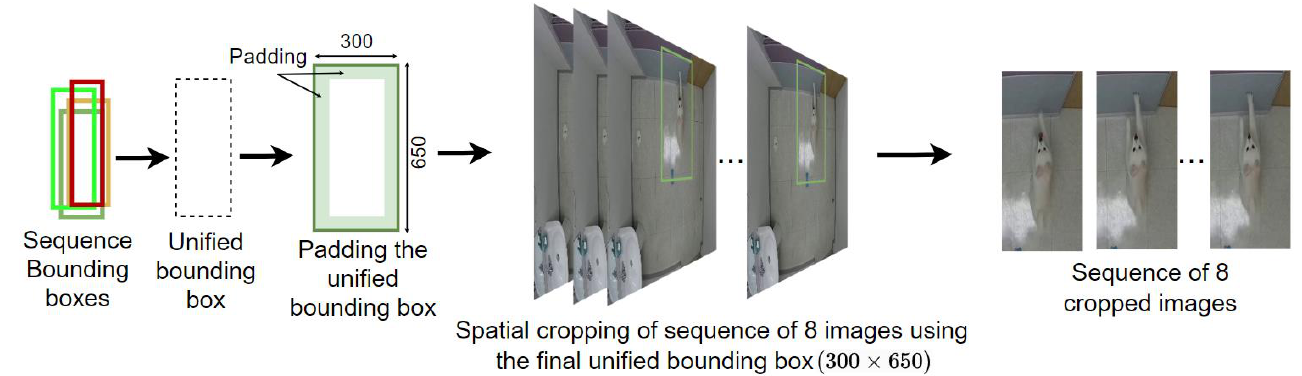
Figure 4. Process of generating and utilizing a unified padded bounding box for spatial cropping on a sequence. In this scenario, padding is applied equally on each side of the box. The cropped images were then resized to 224 × 224 to match the input size of the CNN-LSTM before being forwarded to the behavior recognition